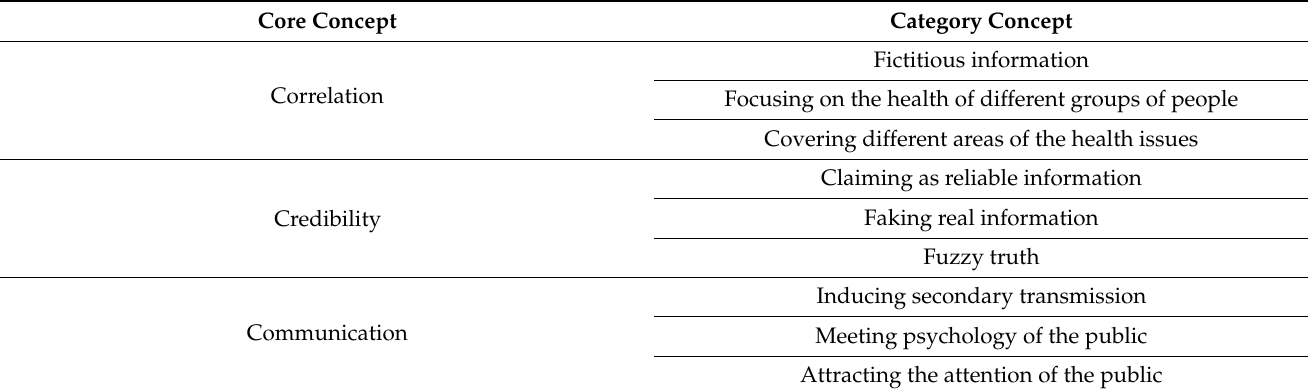
Table 3. Category Concept and Core